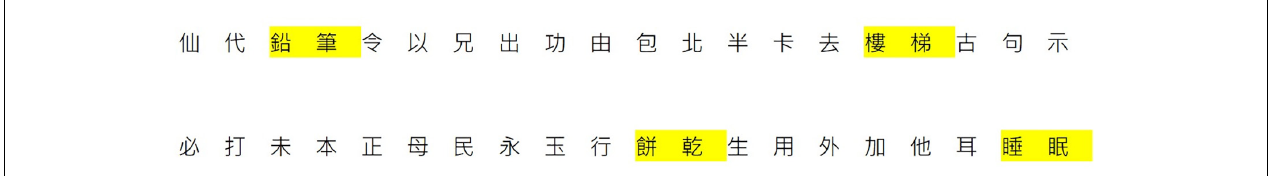
FIGURE 2 | A sample trial in the word detection task. The highlighted items are the targets (i.e., real words). TABLE 1 | Means, SDs, and correlations among measures. Maximum score M (SD) Range Skewness